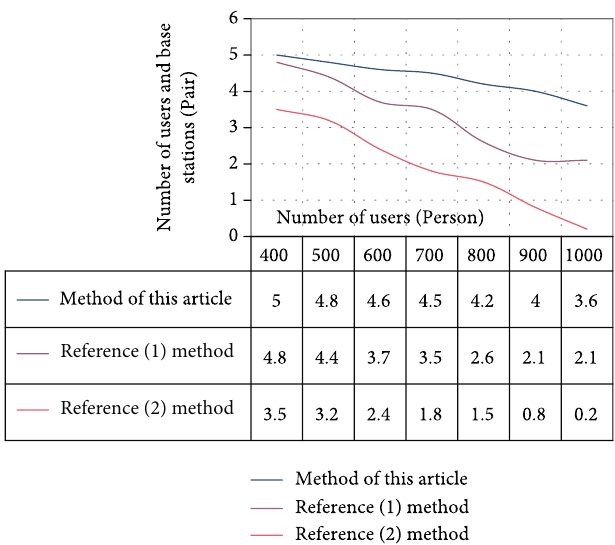
Figure 5: Comparison of communication signals under di ff erent distances of